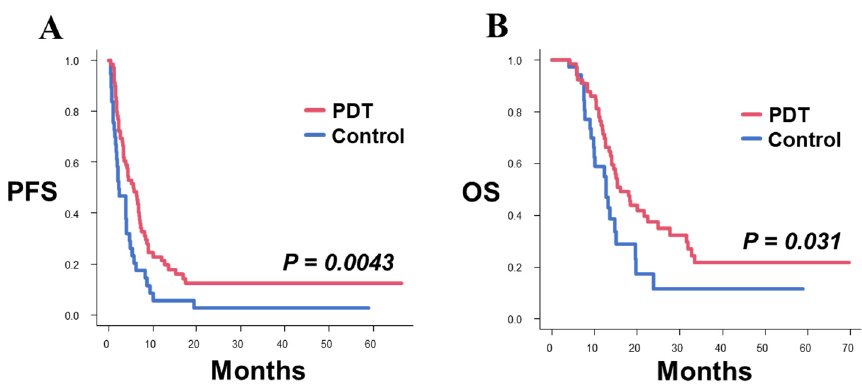
Figure 1. Kaplan–Meier survival curves for PFS and OS after surgery for recurrence in the PDT and control groups. ( A ) Patients in the PDT group showed significantly longer PFS than the patients in the control group (median PFS: PDT 5.7 months, control 2.2 months; p = 0.0043). ( B ) Patients in the PDT group showed significantly longer OS than the patients in the control group (median OS: PDT 16.0 months, Control 12.8 months; p = 0.031).